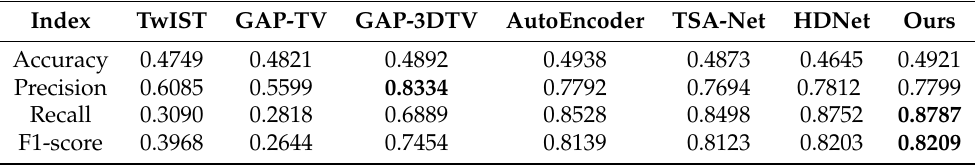
Table 2. Mean accuracy, precision, recall, and F1-score of the reconstructed spectral images of different